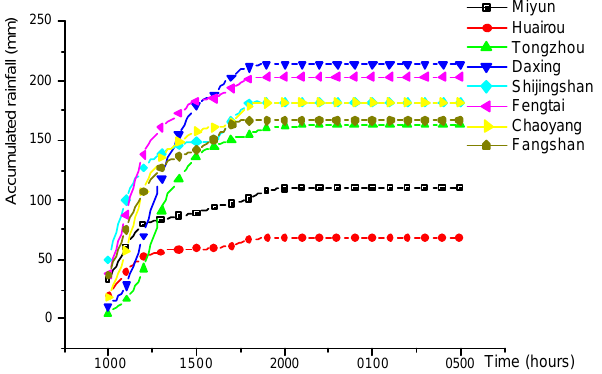
Fig. 8. Accumulated rainfall of eight mainly affected districts between 09:00UTC and 21:00UTC on 21 st -22 nd July 2012.